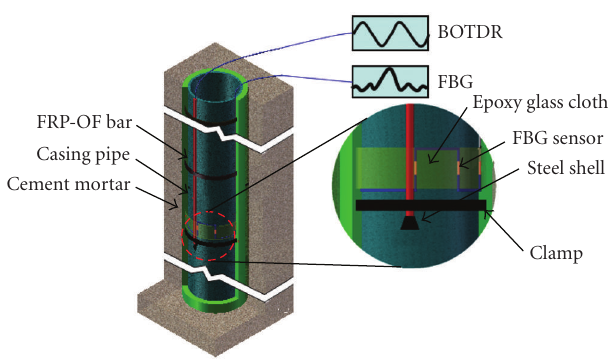
Figure 4: Sketch of a structural monitoring system for the casing pipe.